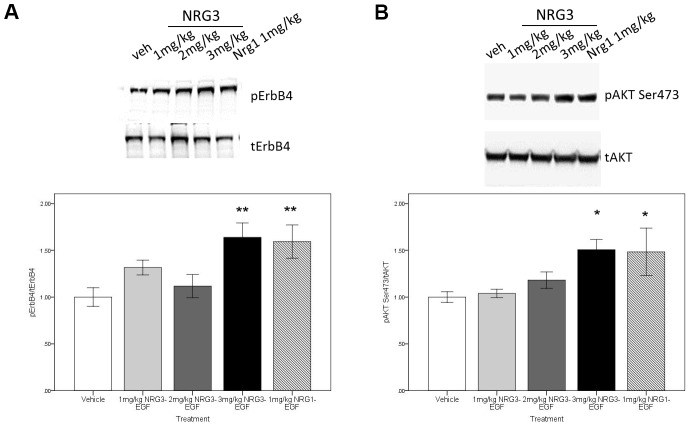
The EGF domain of NRG3 permeates the neonatal mouse BBB in a dose dependent manner, activating ErbB4-Akt signaling.Activation levels of pErbB4 (A), and pAktSer473 (B) in hemi-brain lysates of PND2 mice 3 hours following s.c. injection of vehicle (PBS/0.1% BSA), 1–3 mg/kg NRG3-EGF or 1 mg/kg NRG1-EGF. Representative blots of tErbB4, pErbB4, tAKT and pAKT ser473 protein levels are depicted (upper panels). N = 4–5/treatment group, data represents mean± s.e.m ratio of the respective phosphorylated/total protein expression relative to vehicle treatment group. *p<0.05, **p<0.01 compared to vehicle treated group.